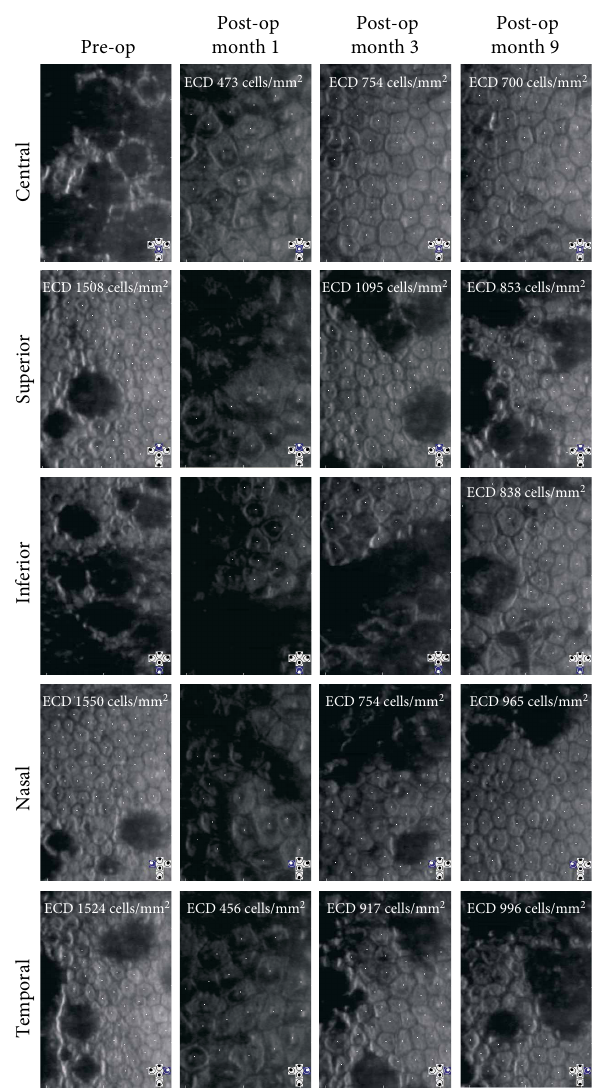
Figure 2: Specular microscopy imaging of the corneal endothelium pre- and post-DSO surgery for the left eye. The locations (central, superior, inferior, nasal, and temporal) are based upon the standard gaze positions of the Konan specular microscope. Endothelial cell density (ECD) is indicated when